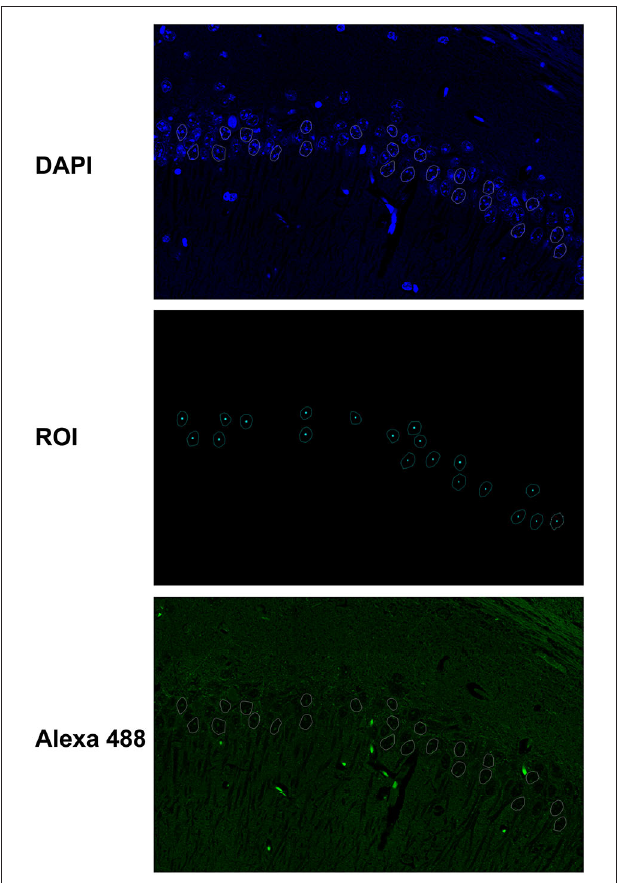
FIGURE 1 | Fluorescence quantification in the nuclei of hippocampal neurons. The elliptical selection tool of ImageJ was used to mark 20–30 representative nuclei based on DAPI staining. The immunofluorescence quantifications from the nuclear mean intensity fluorescence are expressed in gray values, and image analyses of the raw data were obtained with ImageJ and ZEN software programs.